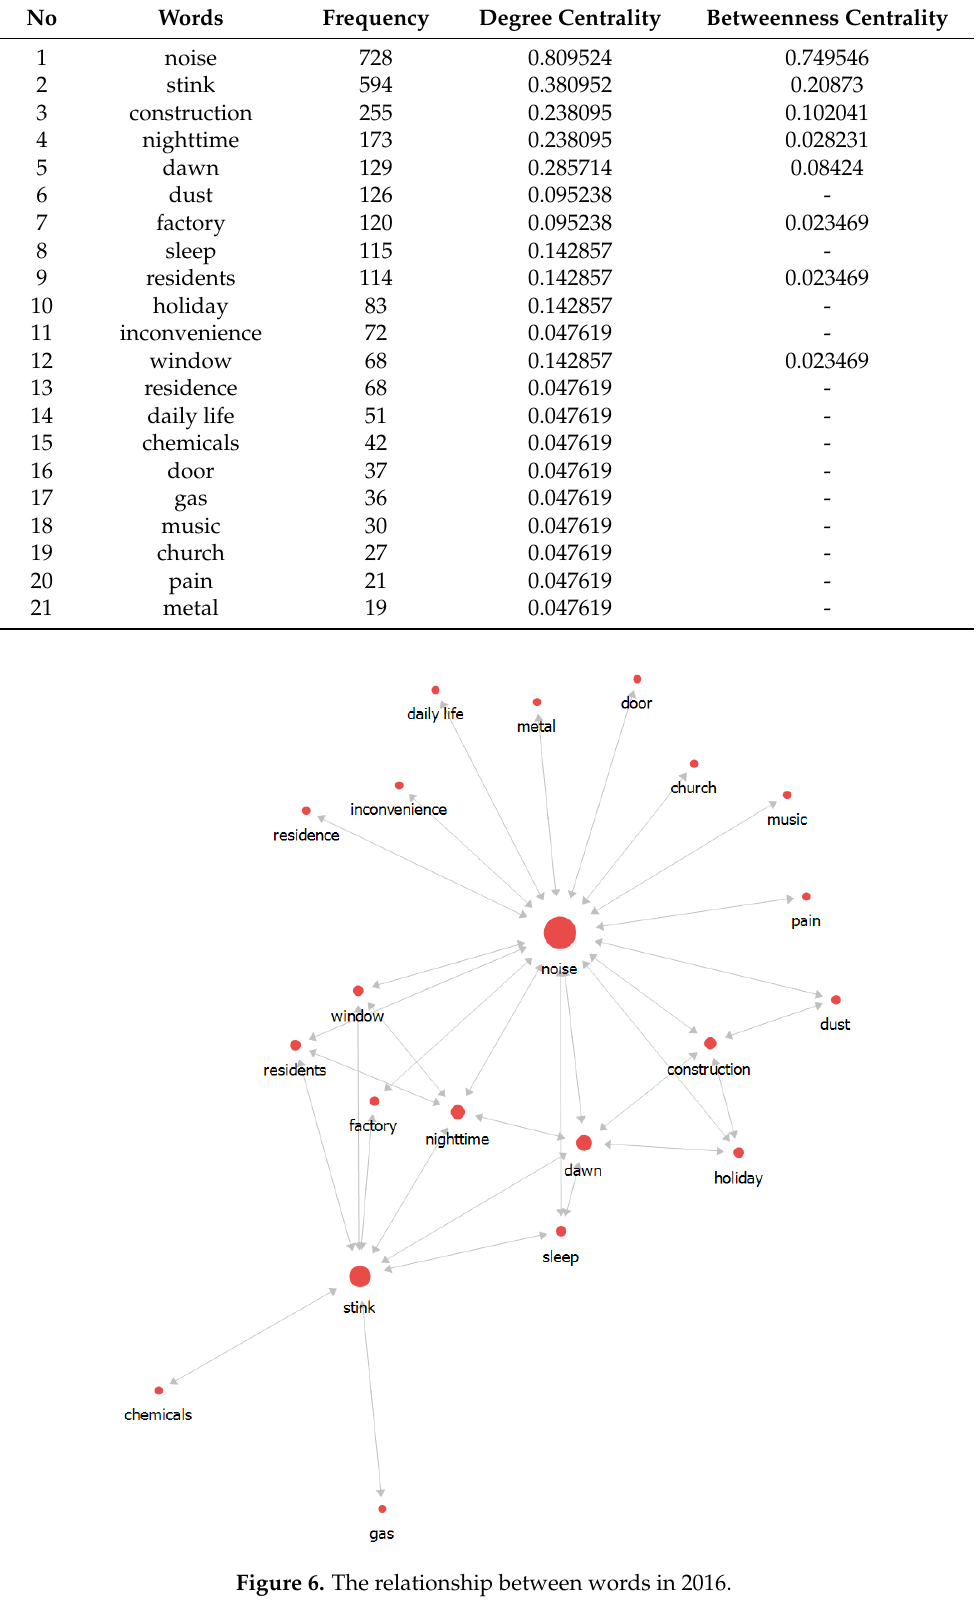
Table 4. The frequency and the centrality value of degree and betweenness of each word in 2016.